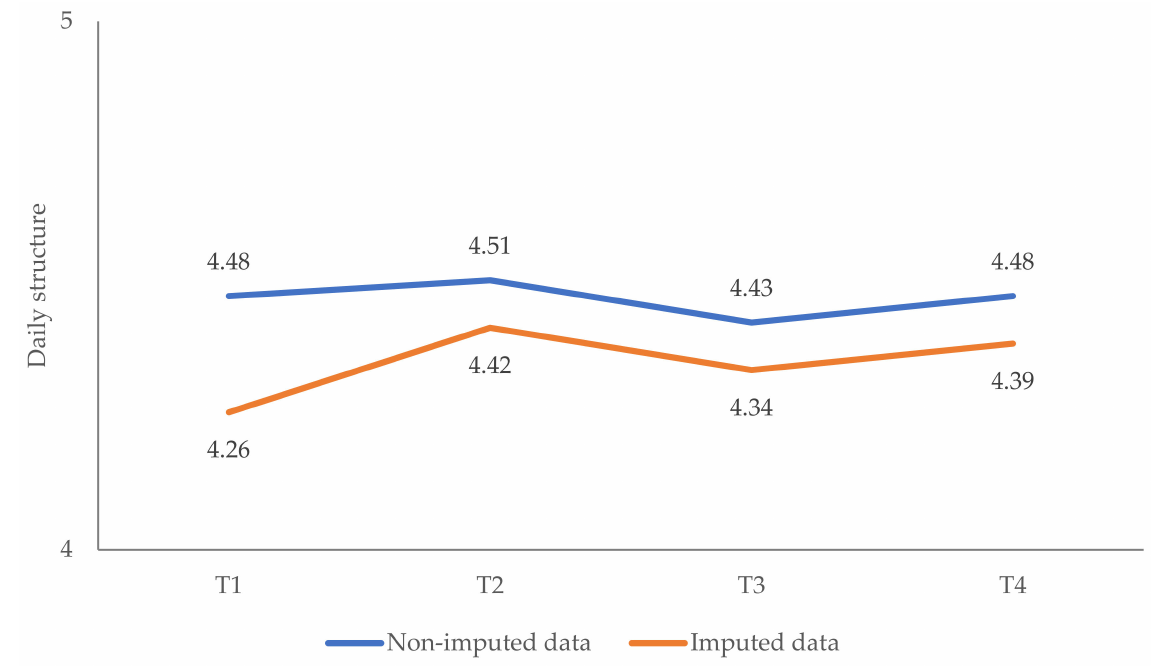
Figure A6. Changes over time in the subscale “Daily structure”: imputed vs. non-imputed results. Note: Imputed dataset: n = 1001. Non-imputed dataset: n = 218.